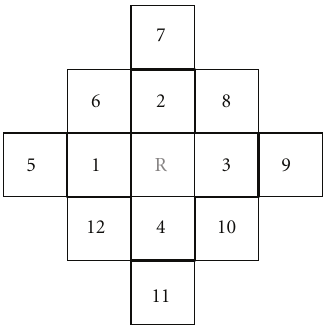
Figure 6: Indexes of the neighbor